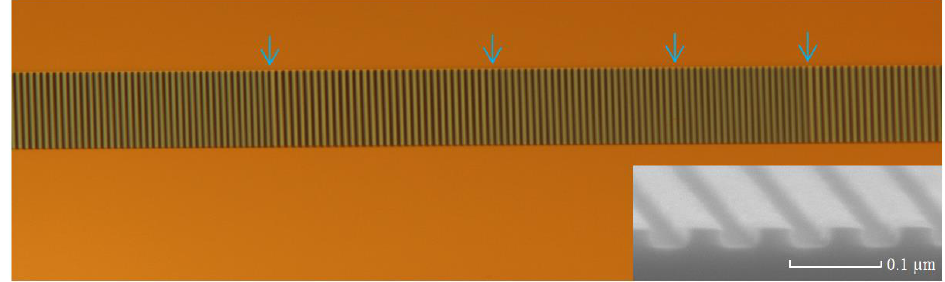
Figure 4. Photoresist gratings fabricated on 1000 Ǻ Si 3 N 4 layer by e-beam lithography. Five different piecewise variable gratings can be found in one period of SSG structure. Inset: SEM photo of etched InGaAs gratings with pitch of ~754 nm and etched depth of ~200 nm.